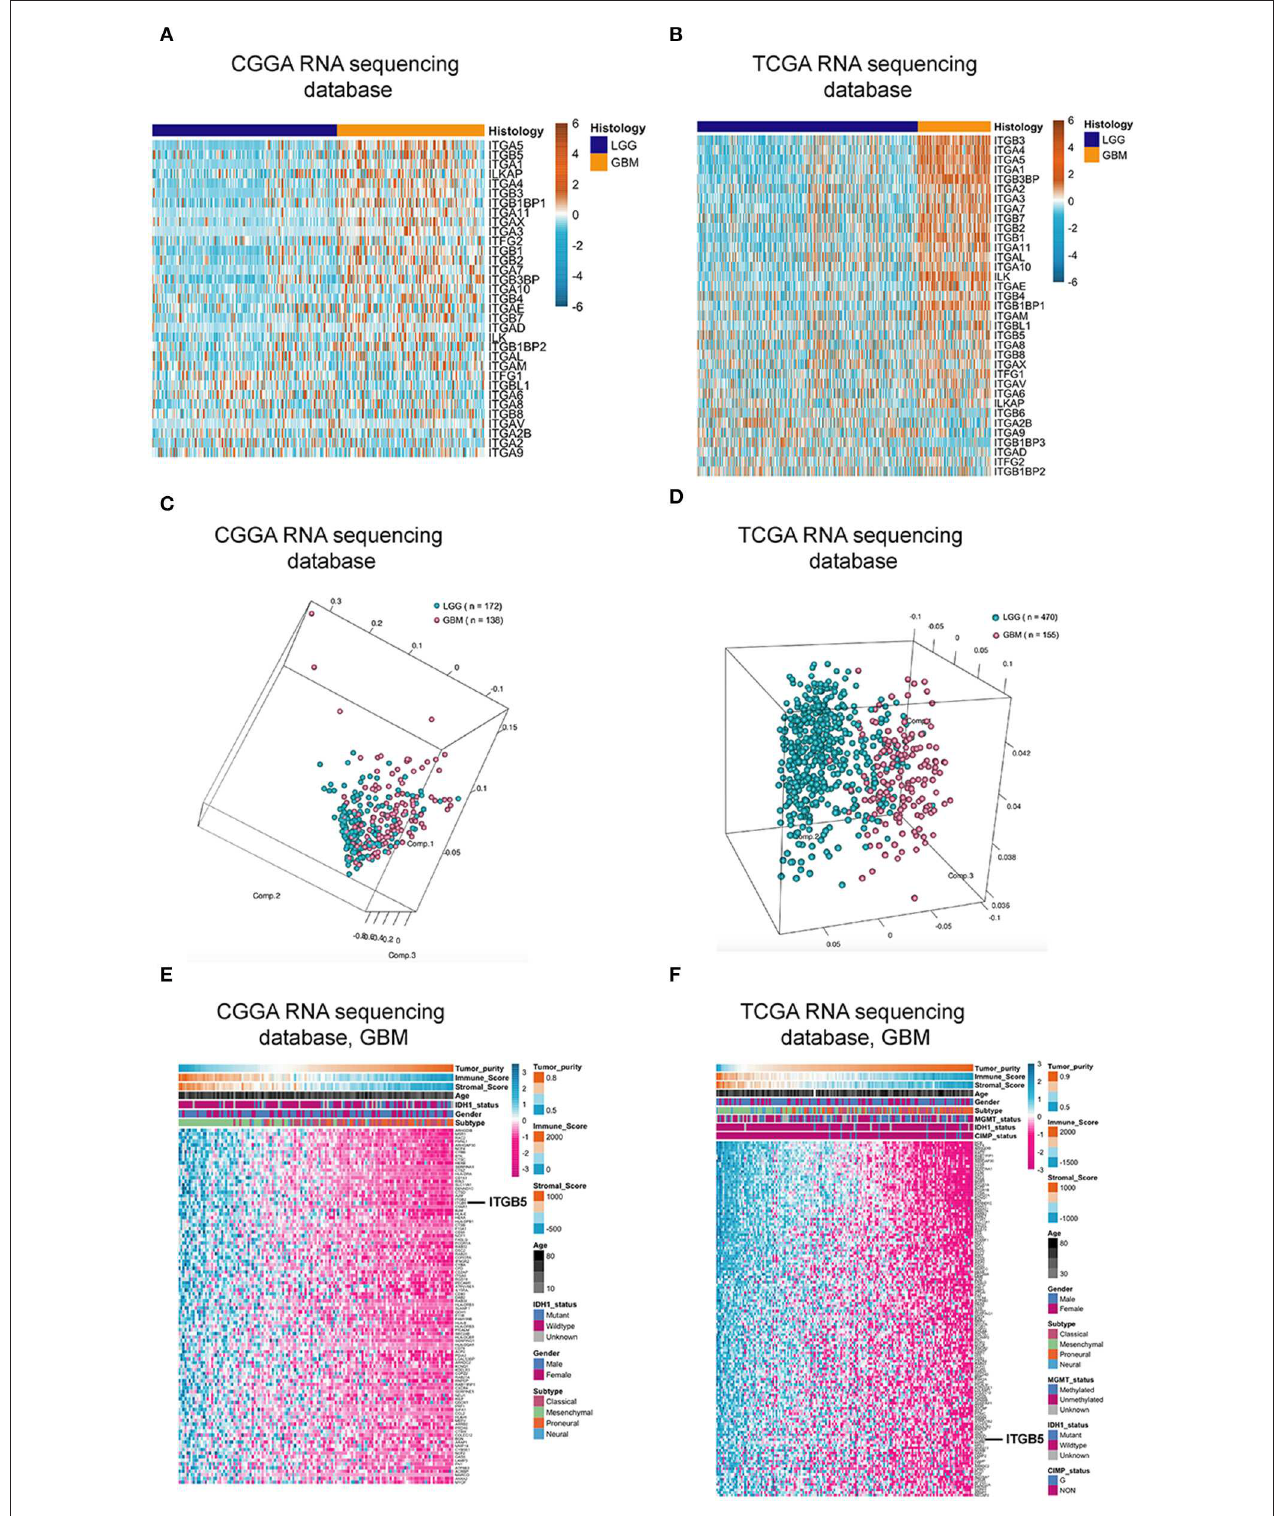
FIGURE 1 | ITGB5 expression in glioma. (A,B) Heatmaps of expression patterns of integrin family genes in glioma based on CGGA (A) and TCGA RNAseq (B) data. (C,D) PCA based on vesicle-related genes in CGGA (C) and TCGA (D) stratifies LGG and GBM. (E,F) Heatmaps showing the positive correlation between vesicle-related genes and tumor purity and immune and stromal scores ( E , CGGA; F , TCGA RNAseq). r > 0.45 or < -0.45 (Pearson’s correlation analysis).